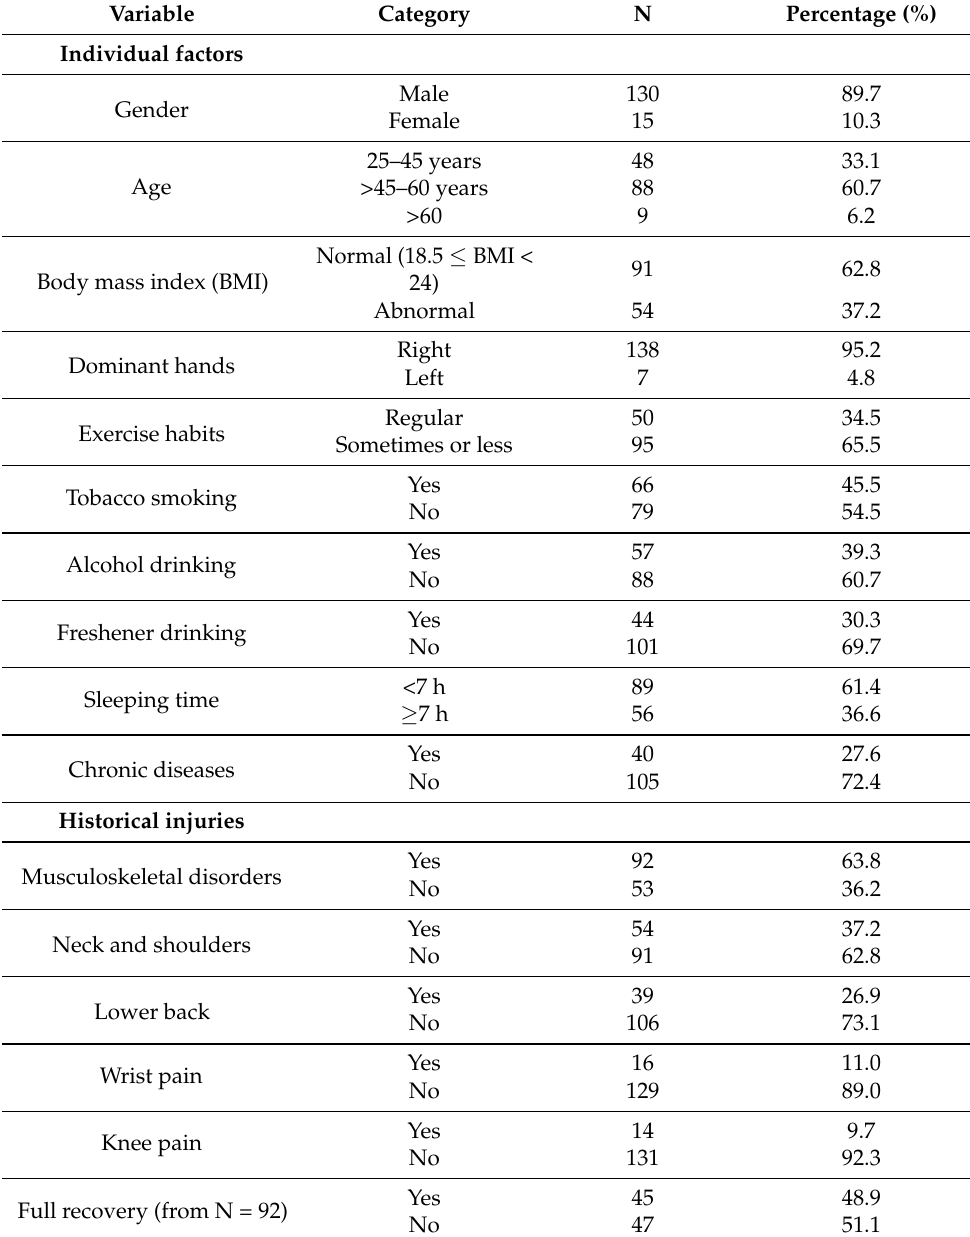
Table 2. Demographics and task characteristics of the 145